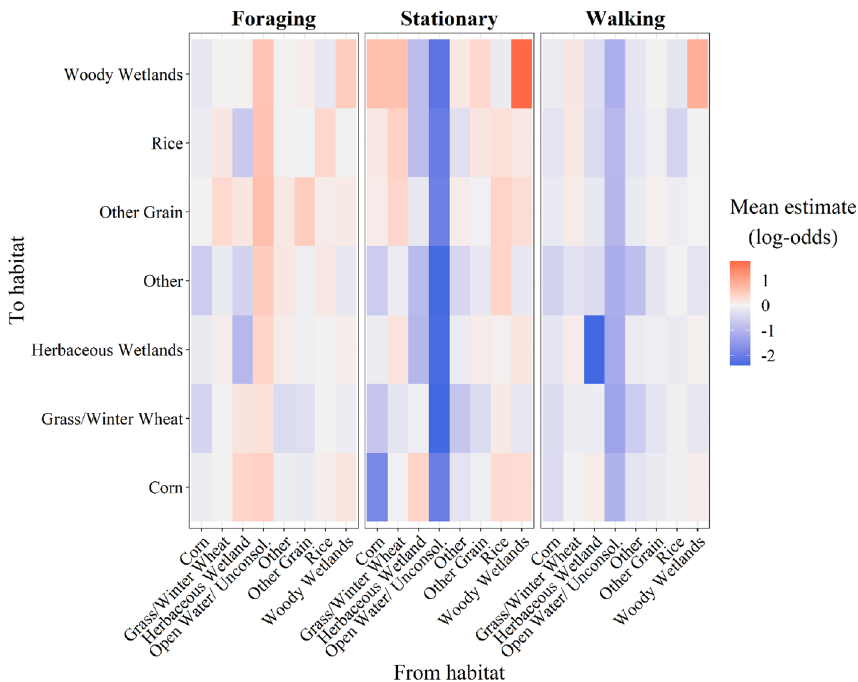
Figure 4. Mean effect on transition-specific probability (log-odds scale) of transitioning between all combinations of landcover types for the proportion of time spent performing each of three behaviors including foraging, stationary, and walking between each GPS location. Positive estimates reflect an increased probability of transitioning from a habitat to a habitat given an increase in the proportion of time spent in a specific behavior, and negative estimates reflect an increase in probability of transition given a decrease in the proportion of time spent in a specific